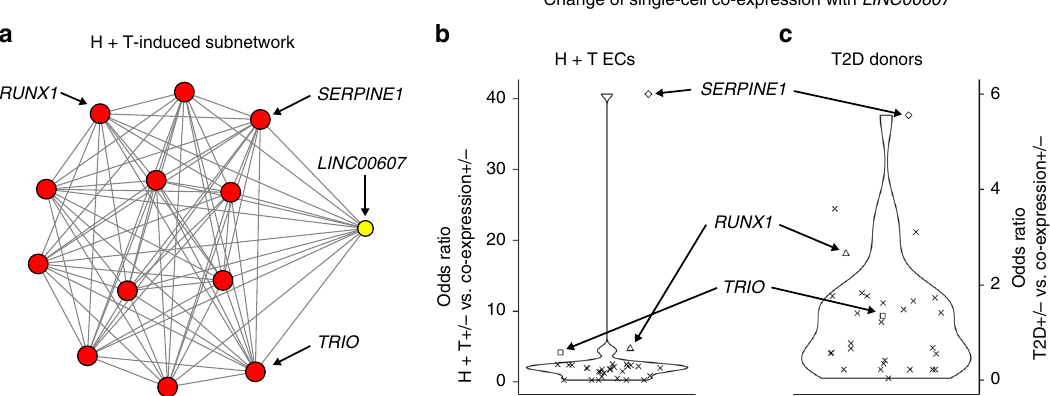
Fig. 5 Increased single-cell LINC00607 – SERPINE1 co-expression in dysfunctional ECs. a H + T Day 7 induced interactions (edges) between Linc607SE (yellow node) and hub SEs (red nodes). b , c Odds ratio ( y -axis) between single-cell co-expression levels and the health status of ECs, including H + T vs. control ECs ( b ) and diabetic (T2D) vs. healthy vascular endothelium ( c ). Each dot corresponds to a gene in any Linc607SE -interating SE ( a ). A large odds ratio corresponds to a positive association between dysfunction (H + T Day 7 for b and diabetic for c ) and the single-cell co-expression of this gene with LINC00607 . Source data are provided as a Source data fi